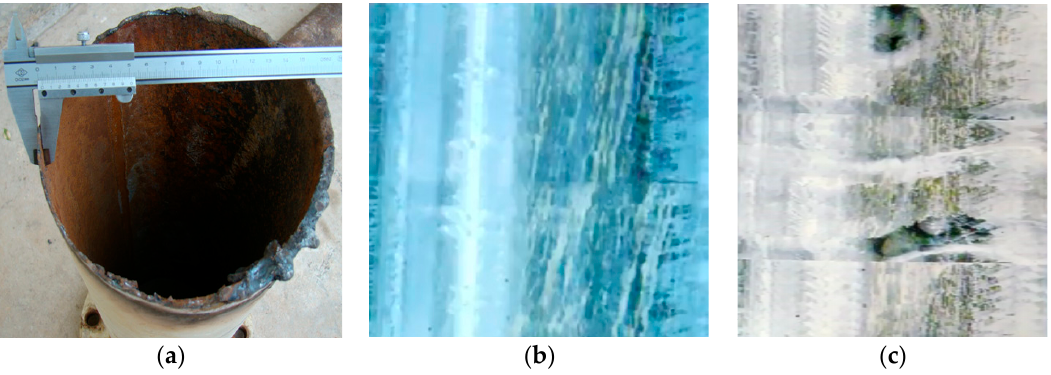
Figure 1. Several vertical pipeline failures ( a ) uneven wear ( b ) scratch and ( c ) gap.